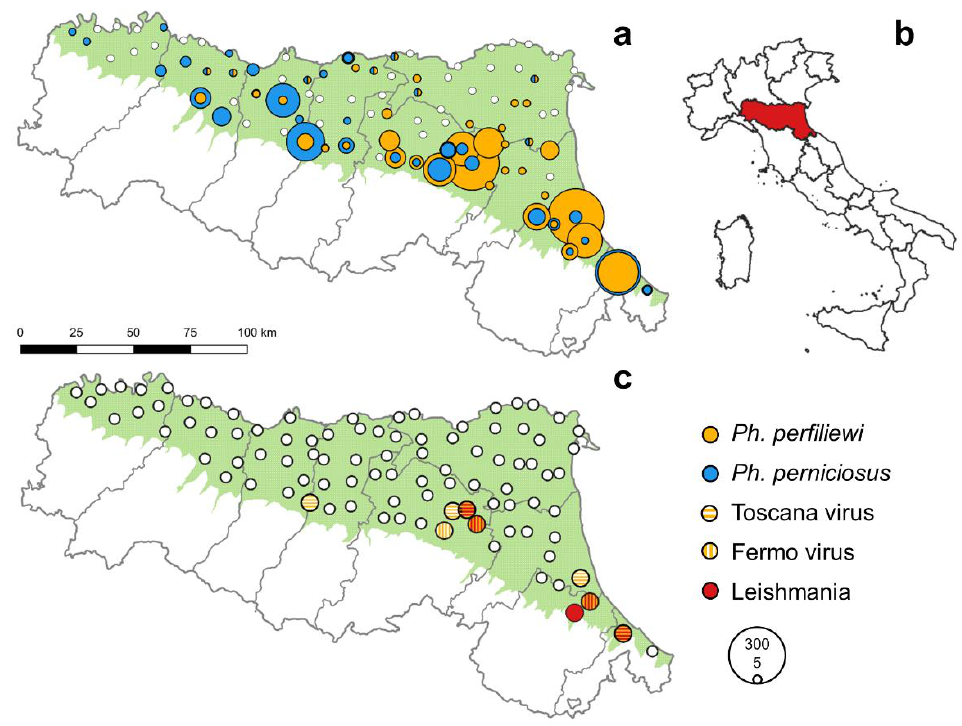
Figure 1. Number of Ph. perfiliewi and Ph. perniciosus collected in 2021 (number proportional to circle size) at the different sites on the survey area (green) ( a ) with reference to the location of Emilia-Romagna Region on the map of Italy ( b ) and pools positive for tested pathogens ( c ).